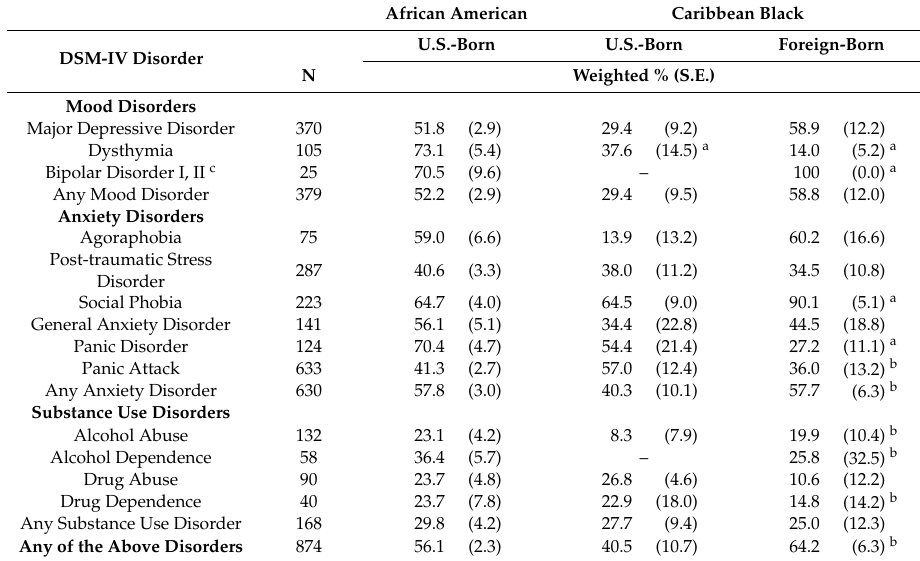
Table 4. Proportion of Black women with a lifetime DSM-IV mood, anxiety, and substance use psychiatric disorder who met the criteria for a psychiatric disorder in the past 12 Months. African